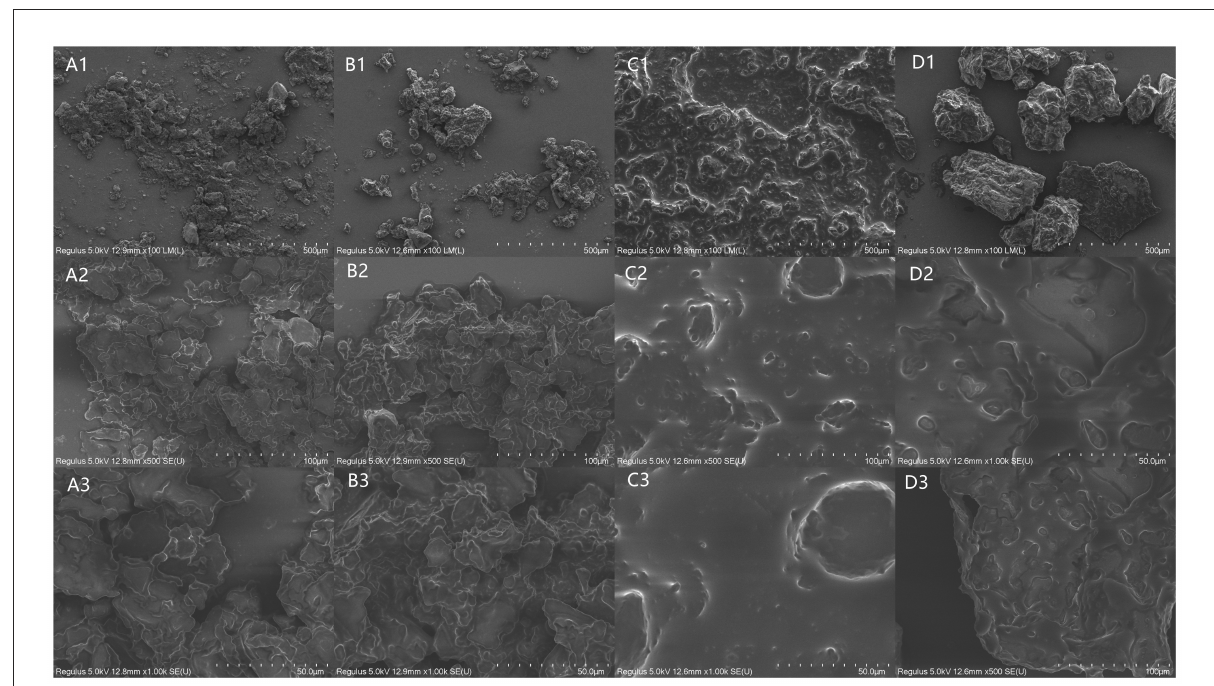
FIGURE4 Scanning electron microscopy (SEM) images of untreated and three pretreated camellia seeds. The letters present the treated methods, [ (A) UT, (B) HA treated, (C) PU treated, (D) ST treated camellia seeds]. The numbers present the magnification, 1 is 100 × , 2 is 500 × , 3 is 1,000 ×